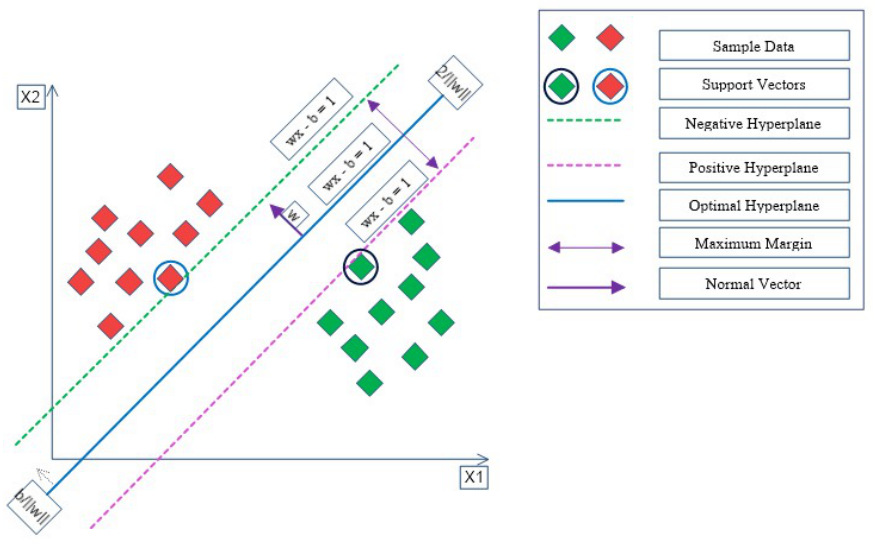
Figure 2. Optimal hyperplane using the SVM